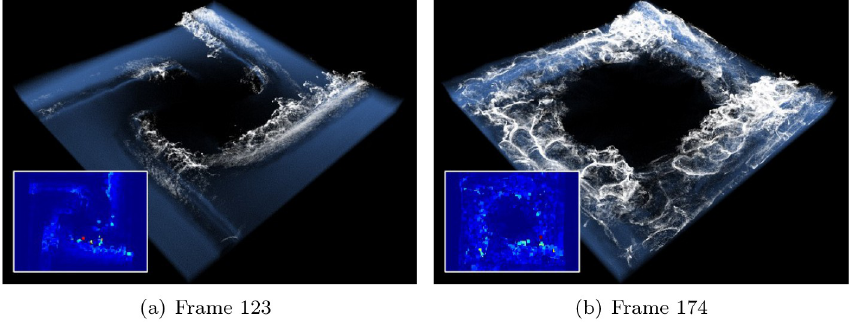
Fig 15. Foam effects with our method in tornado (inset image: Acceleration map). (a) Frame 123, (b) Frame